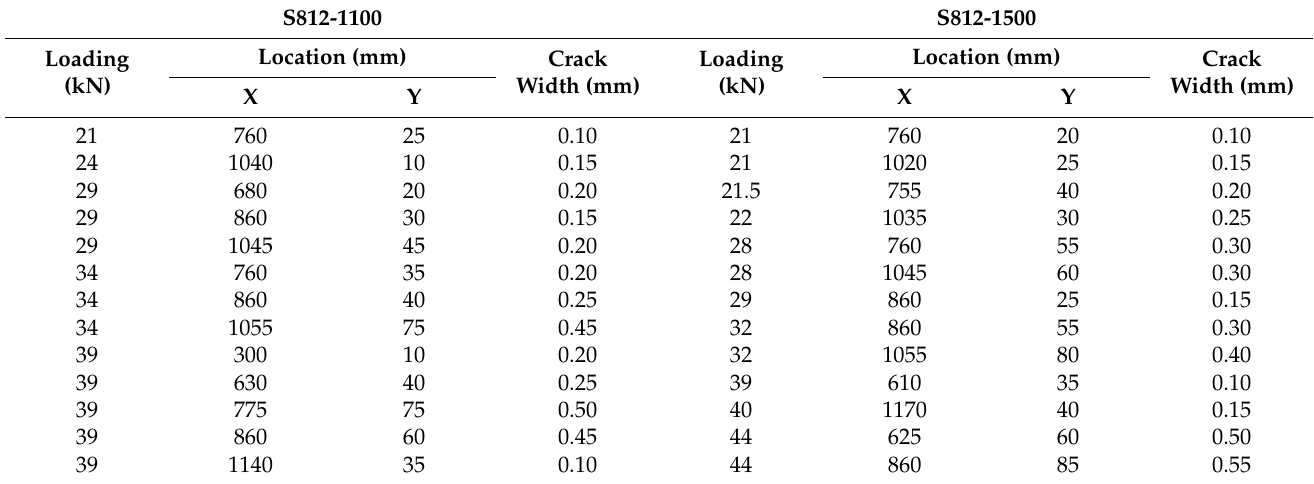
Table 11. Crack widths and their locations for the S812-1100 and S812-1500 specimens.